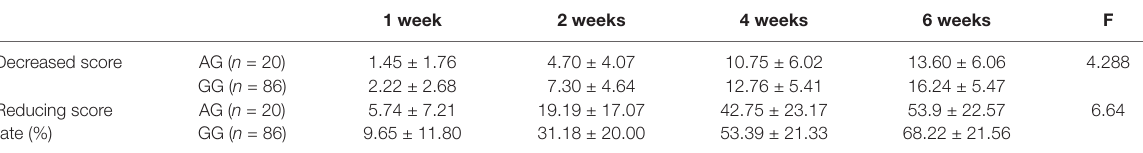
*Statistically significant difference between the groups (p < 0.05).